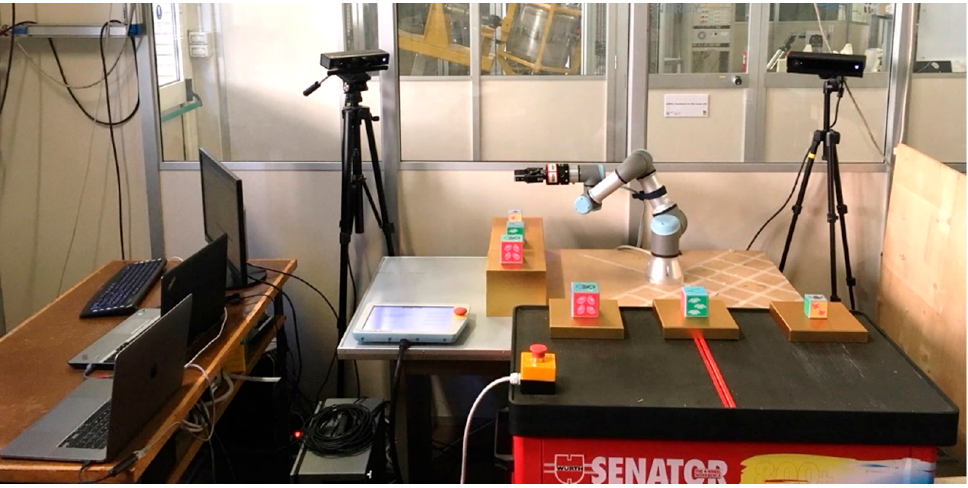
Figure 4. Experimental layout of the collaborative assembly cell.